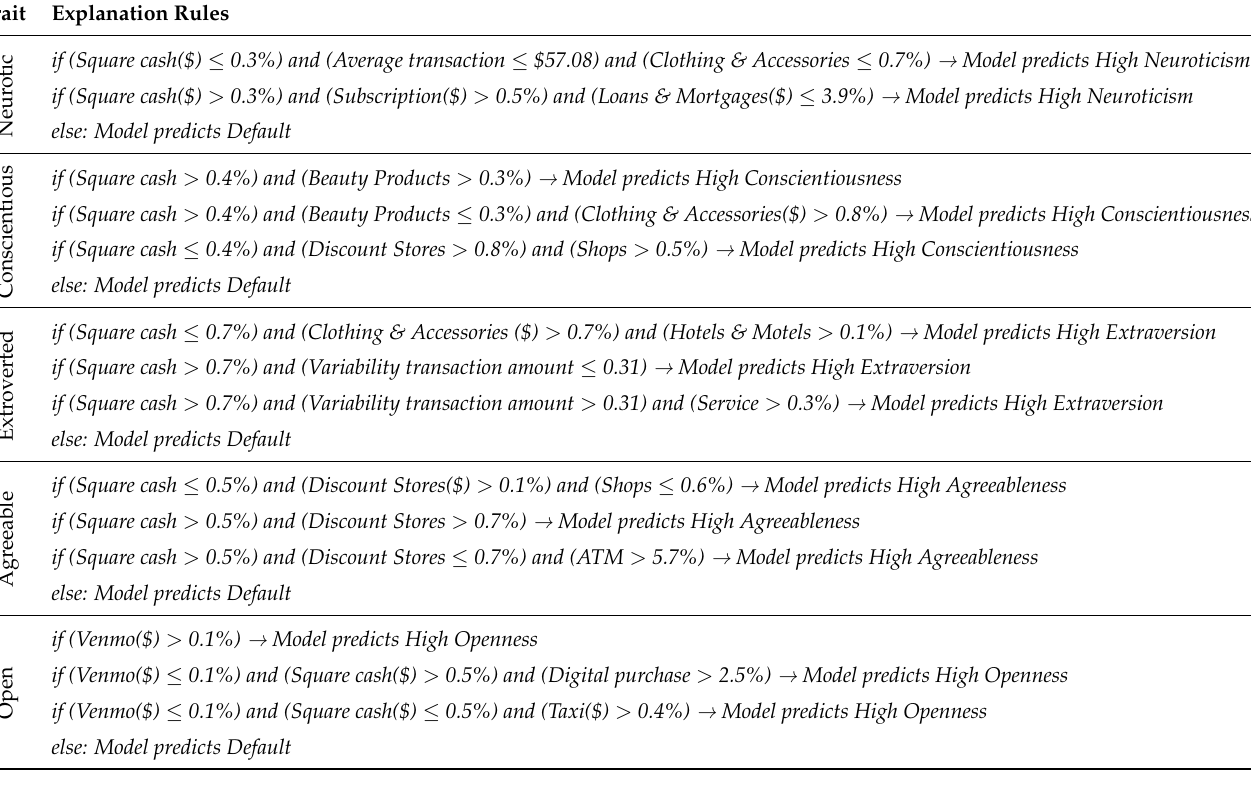
Table 2. Global explanation rules. If-then-else rules that explain when the algorithm classifies High levels of personality traits based on financial transactions. The Default class comprises Low to Medium levels of the same trait. Note: Discount stores and Discount stores ($), respectively, indicate the relative number of transactions in vs. the amount of money spent in a category. ‘Square Cash’ and ‘Venmo’ are mobile payment applications to transfer money to friends and family. Trait Explanation Rules